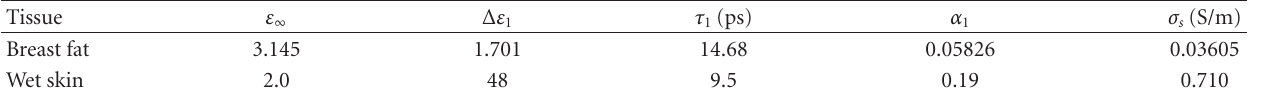
Figure 1: Measured (points) [14] and Cole-Cole model fitted (solid curve) dielectric values for wet skin in the microwave frequency range. Table 1: Coe ffi cients for Cole-Cole models of tissues for 400 MHz–20